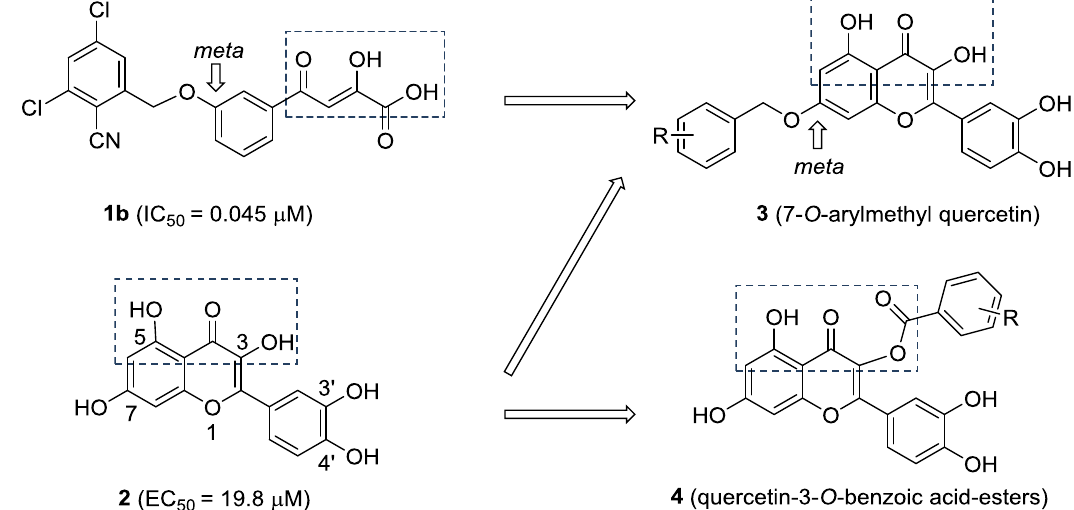
Figure 2. The design of 7- O -arylmethylquercetin derivatives 3 and quercetin-3- O -benzoic acid ester derivatives 4